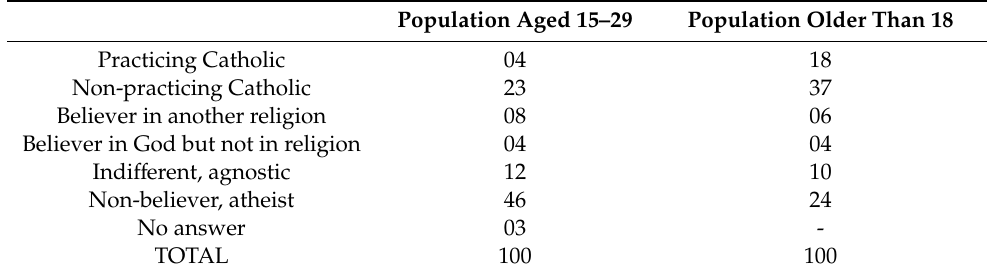
Table 3. Religious self-definition of youngsters (15–19 years old), and of adults (percentage).